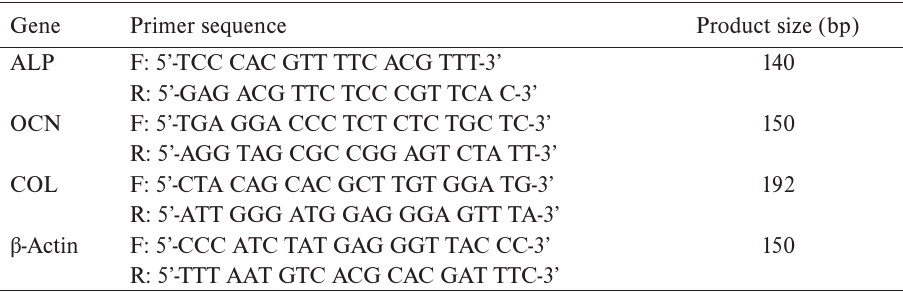
Fig. 1. Mandible reconstruction surgery outcomes: surgical installation of external and internal Table 1. Primers used for real-time quantitative PCR and RT-PCR.